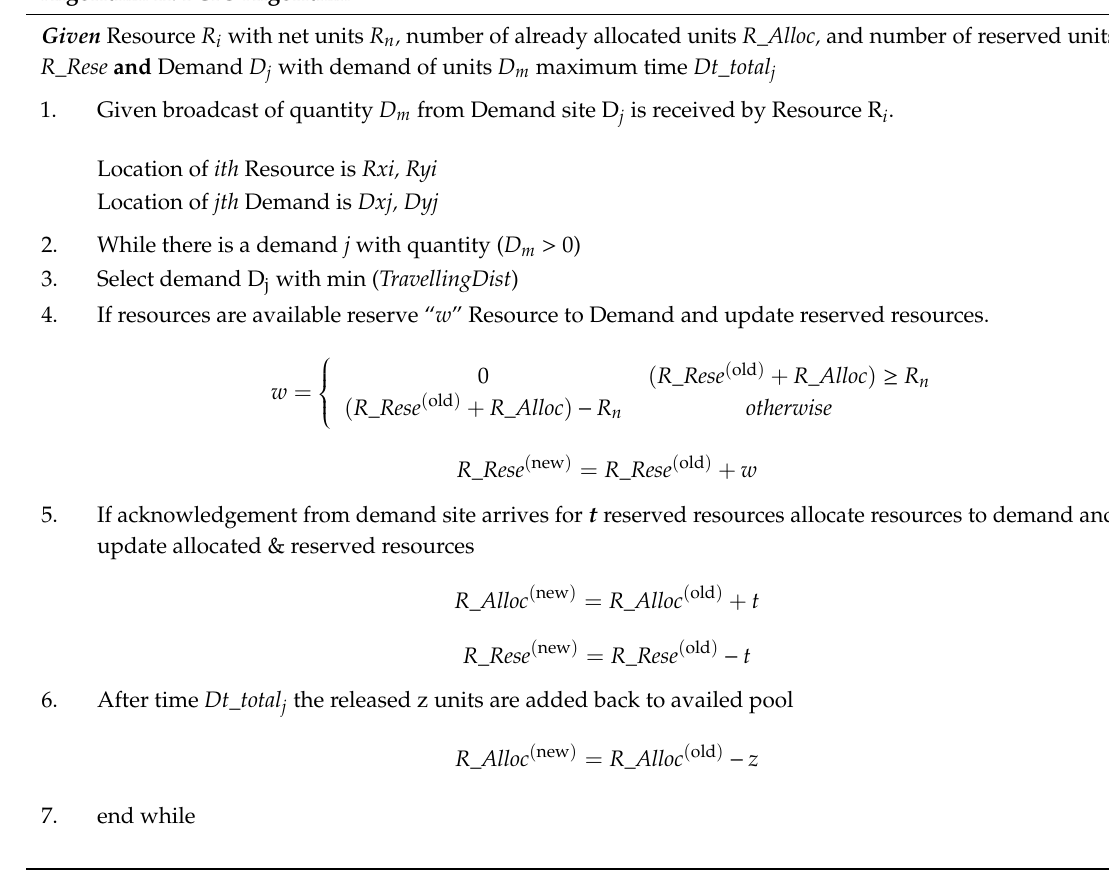
Algorithm II: FCFS